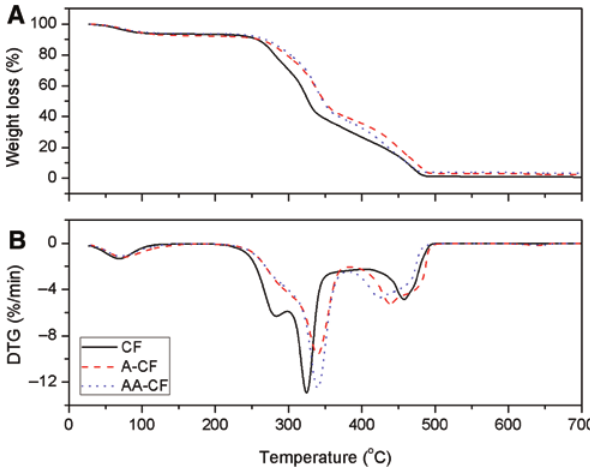
Figure 4: TG (A) and DTG (B) curves of coir fibers: untreated (CF), alkali-treated (A-CF), and acrylic acid-treated